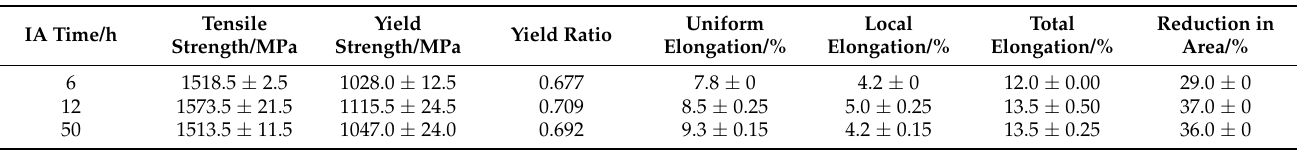
Table 2. Tensile properties at room temperature after being tempered at 200 ◦ C.